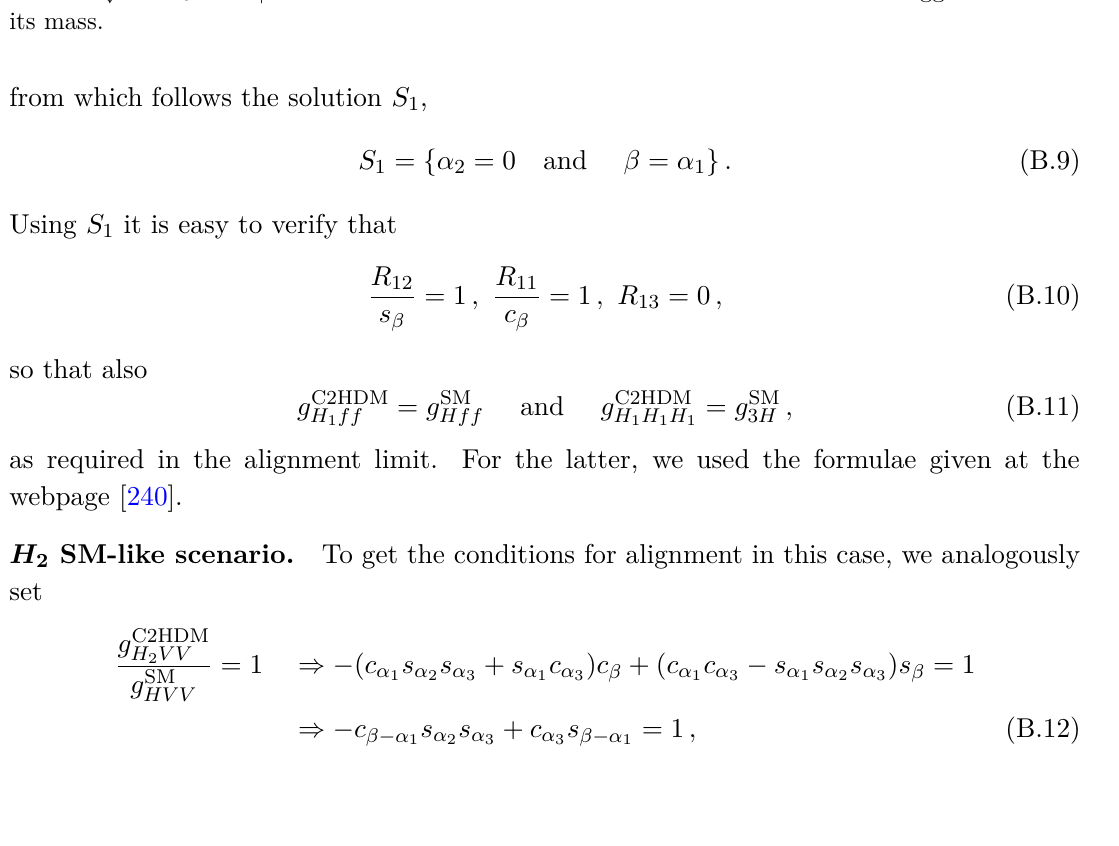
Figure 16 . Resonant production cross sections for the NMSSM points of figure 8 for H 1 ≡ H SM (upper) and H (lower) as a function of the resonantly produced heavier Higgs boson 2 ≡ H SM H 2 ≡ H ↓ or H 3 ≡ H ↑ . Color code: ratio of the total width of the resonant Higgs boson and its